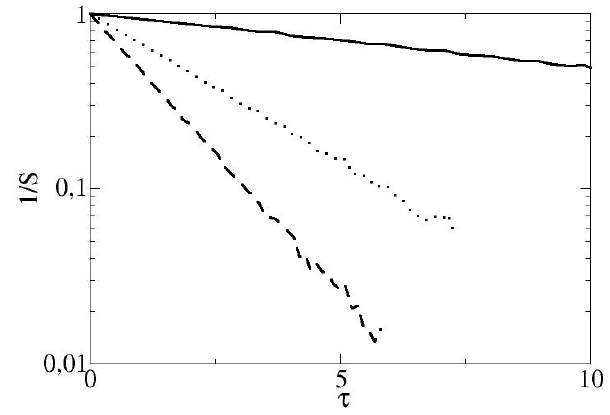
) − 1 for t = 300, τ = 0 full line, 10 Z o τ